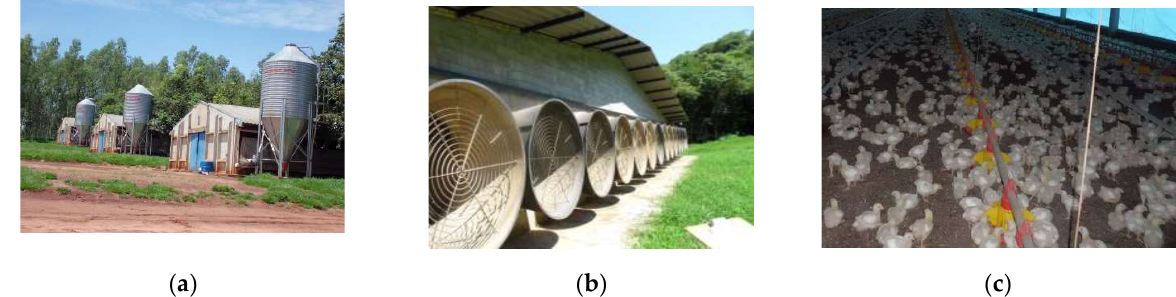
Figure 1. Overview of the commercial houses where the data were recorded ( a ), the air outlet fans ( b ), and inside the housing ( c ).